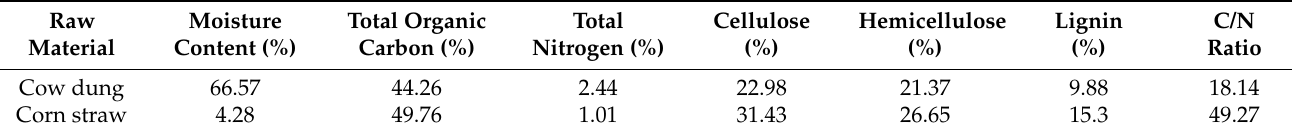
Table 1. Basic chemical composition of corn straw and cow dung before